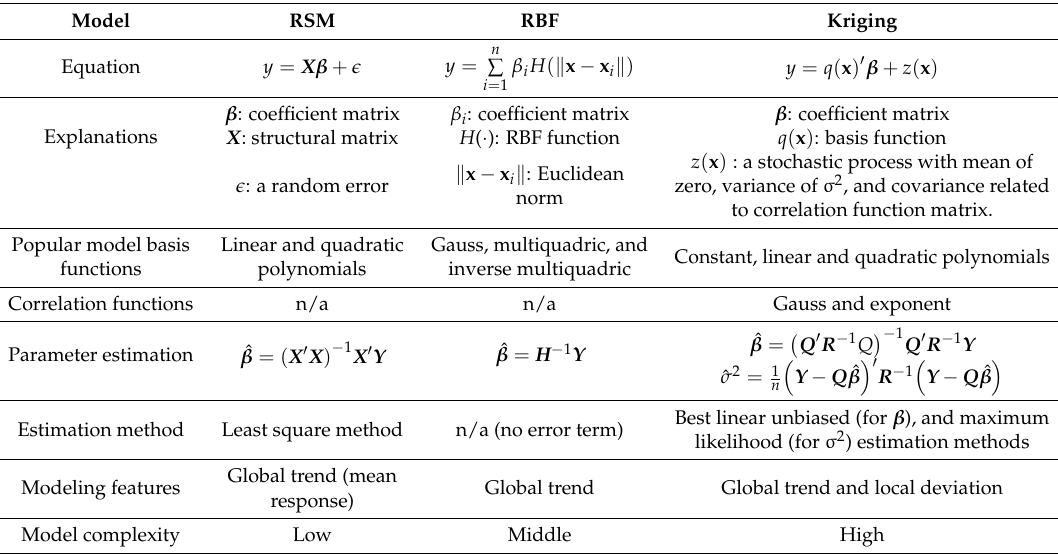
Table 2. Comparison for RSM, RBF and Kriging